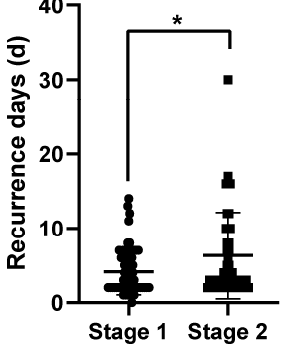
Figure 2. Comparison of recurrence days between different periods. *—significant difference.